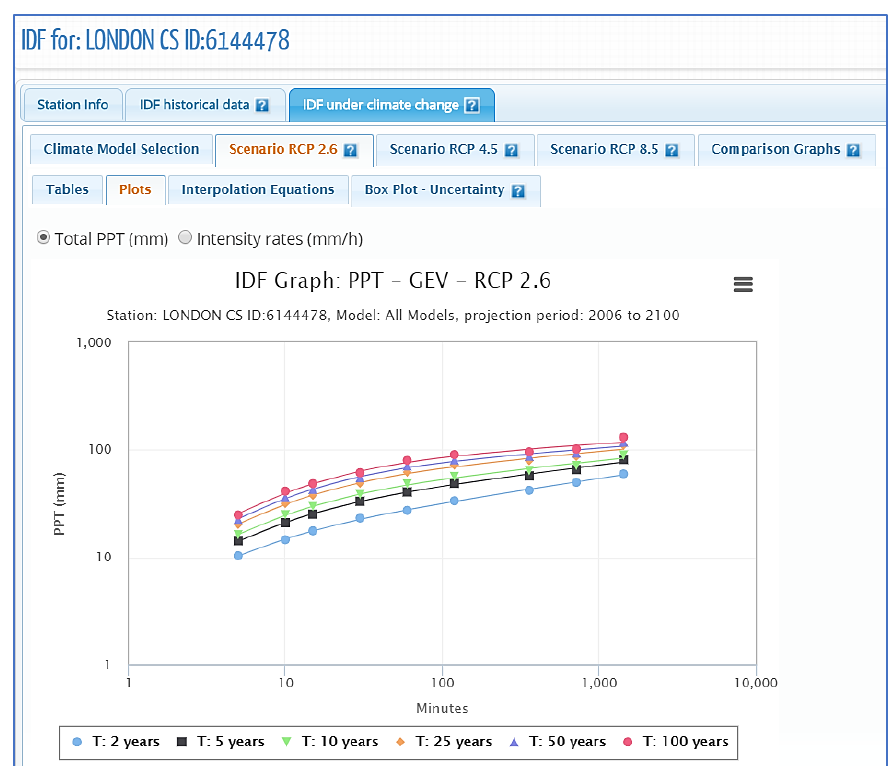
Figure 14. Updated IDF curves for Representative Concentration pathway (RCP) 2.6 and ensemble of all raw GCMs.